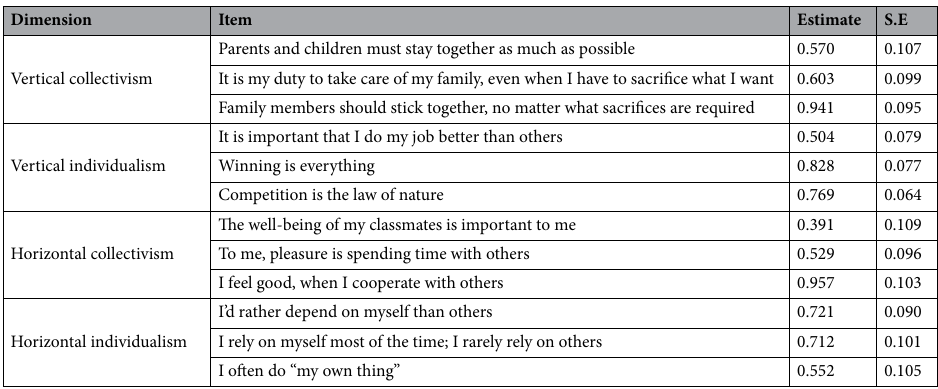
Table 4. Standardized factor loadings. All estimates are statistically significant ( p <